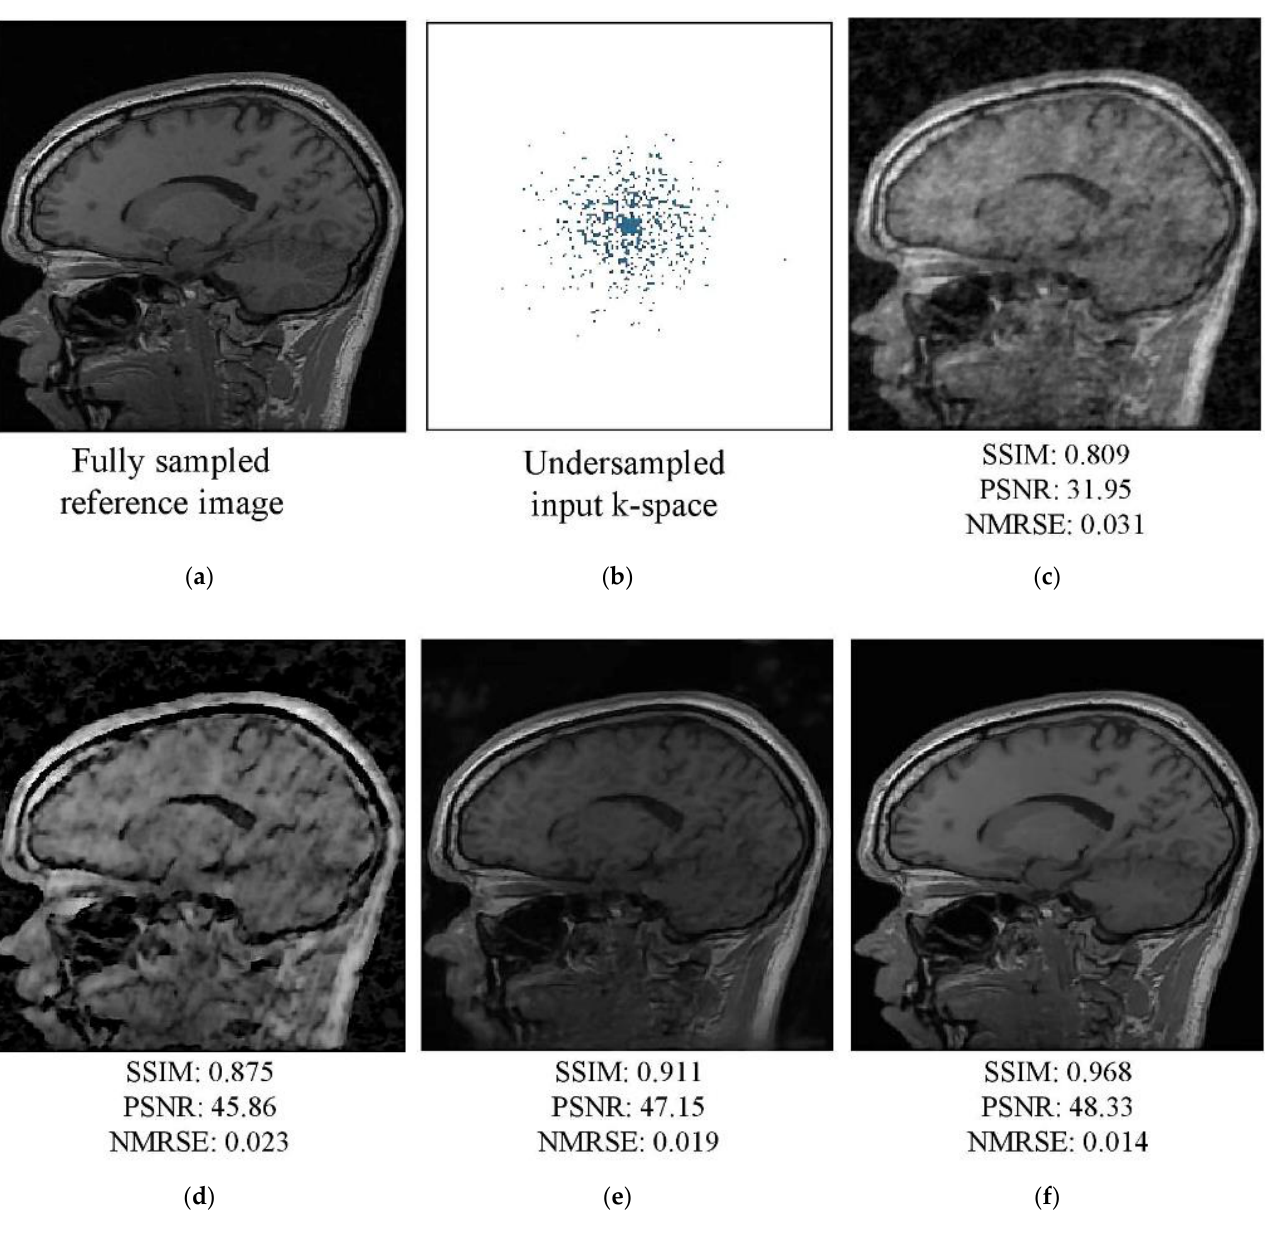
Figure 8. MRI images from the test dataset (slice No. 100) for AF 5: ( a ) fully sampled reference image and ( b ) undersampled k-space. Image reconstructed by the ( c ) IFFT, ( d ) Unet, ( e ) W-net, and ( f ) RA-CNN methods.